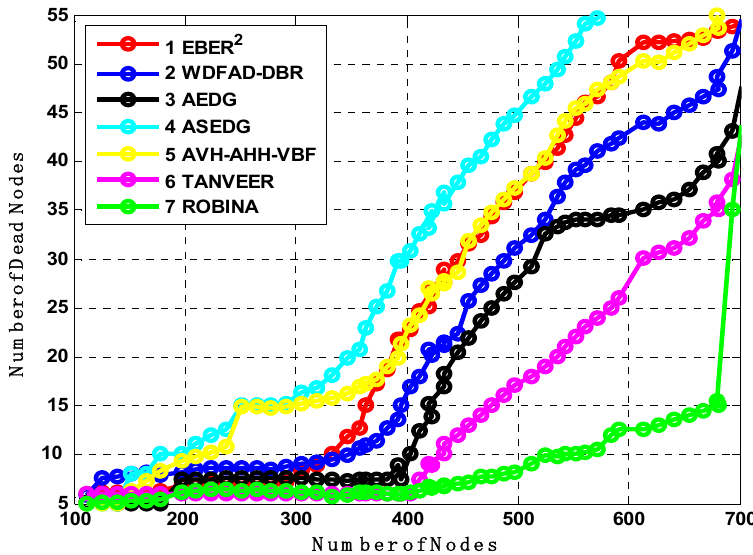
Figure 7. Analysis of the number of dead nodes with baseline schemes.